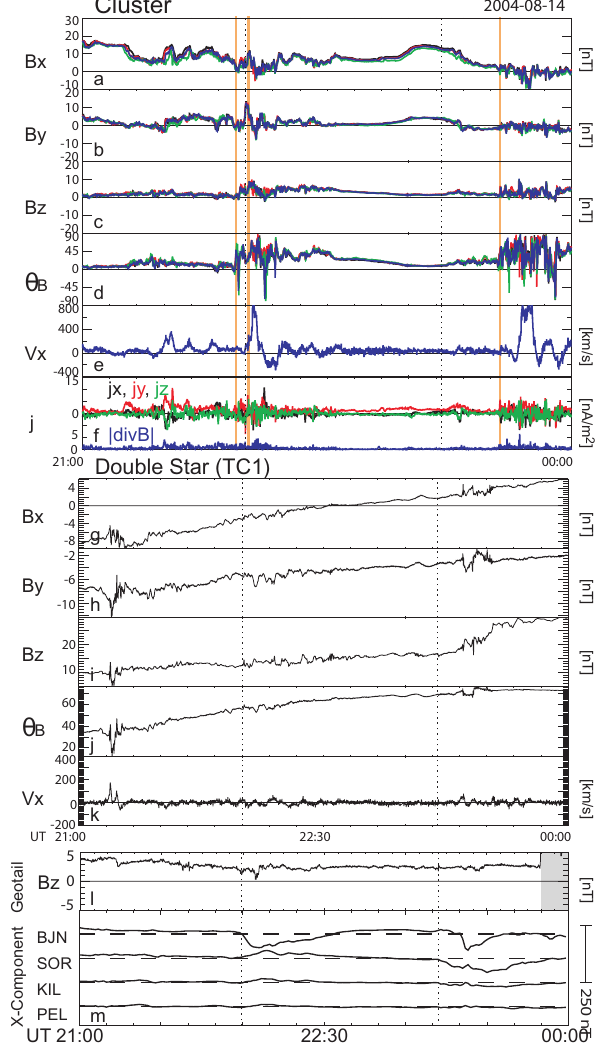
Fig. 3. Same as Fig. 1 except for 14 August